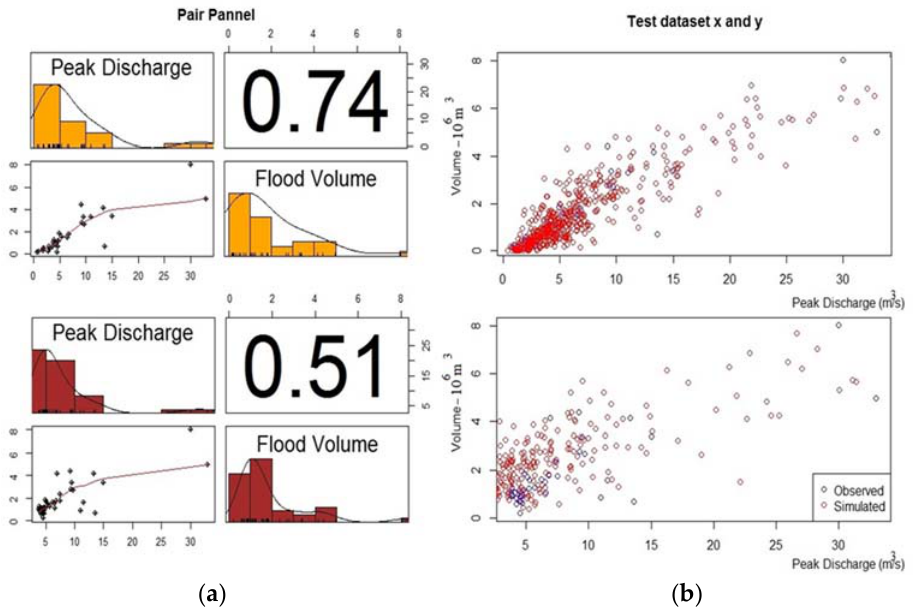
Figure 2. ( a ) A scatterplot matrix of the selected variables and their Kendall correlation coefficient for the first and second dataset; ( b ) Comparison between the observed and simulated values (sample size 1000) (Q ‐ V) for Gumbel (up) and Joe Copula (down) for 1000 simulations iterations, indicating an adequate fit between the simulating and observed values.